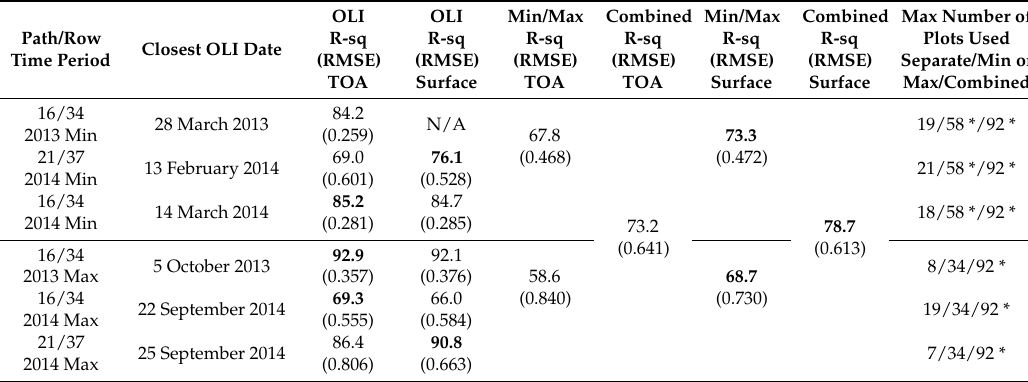
Table 3. Regression results between ground measured LAI and Landsat OLI TOA- and surface reflectance-based SR (bold R 2 s denote the regression with the best fit for the given ground data collection). * These plot numbers are just for TOA reflectance since the surface reflectance plot numbers were reduced to 39 and 73 for minimum and combined, respectively, due to the surface reflectance image of one 16/34 image date being unavailable.